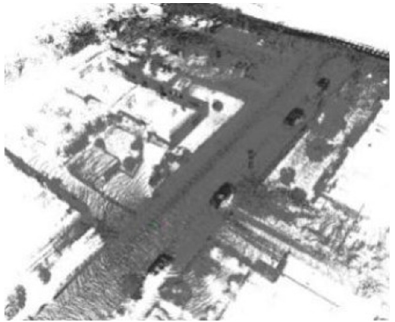
Figure 16. Random sampling.